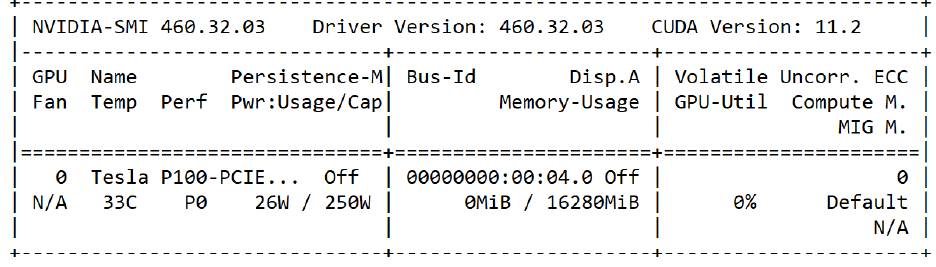
( d ) Figure 13. Training results for loss of the four best-performing models: ( a ) MobileNet, ( b ) SqueezeNet, ( c ) NasNetMobile, and ( d ) MobileNetV2. Accuracy: As mentioned above, the overall accuracy of a model is simply the number of correct predictions divided by the total number of predictions resulting in a percentage value. This measurement is performed simultaneously with the data selected for training and validation. The main objective is that the two results do not diverge significantly. In the case of the training carried out with the selected models, the best accuracy with the